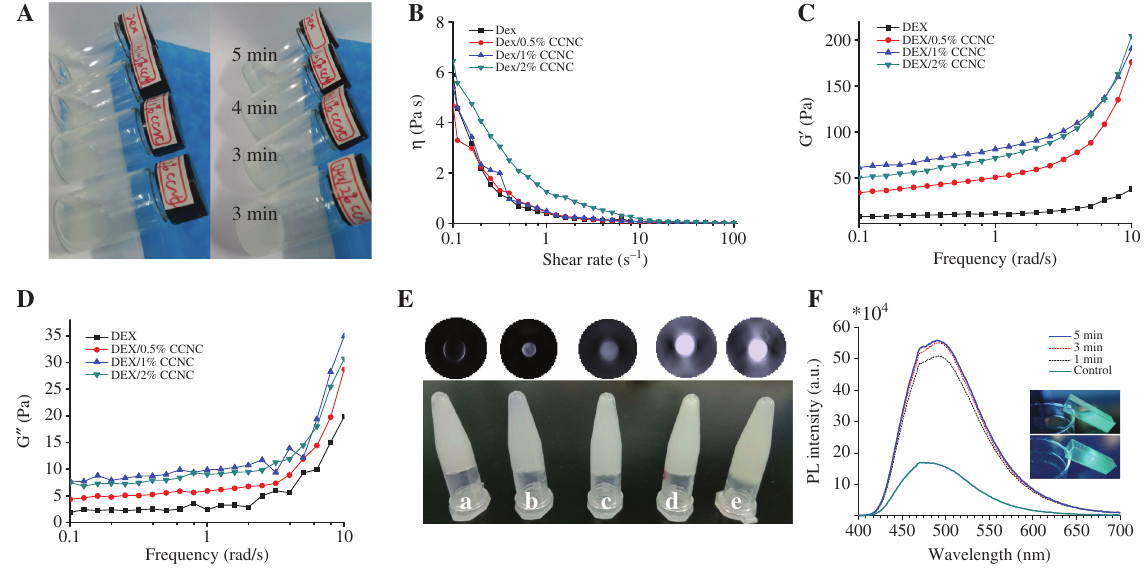
Figure 4: Characterization of DEX/CCNC/MPDA-TPE hydrogels. (A) Calculated gelation time of DEX/CCNC hydrogels with different content of CCNC. (B) Flow curves of solutions of DEX/CCNC. (C) Storage modulus (G ′ ) against the frequency of DEX/CCNC hydrogels. (D) Loss modulus (G ′ ) against the frequency of DEX/CCNC hydrogels. (E) Photoacoustic imaging and photo in natural state of DEX/CCNC/MPDA-TPE hydrogels with different content of MPDA-TPE. (a) 0, (b) 100, (c) 200, (d) 300, and (e) 400 g/ml. (F) PL spectra of DEX/CCNC/MPDA-TPE hydrogels during